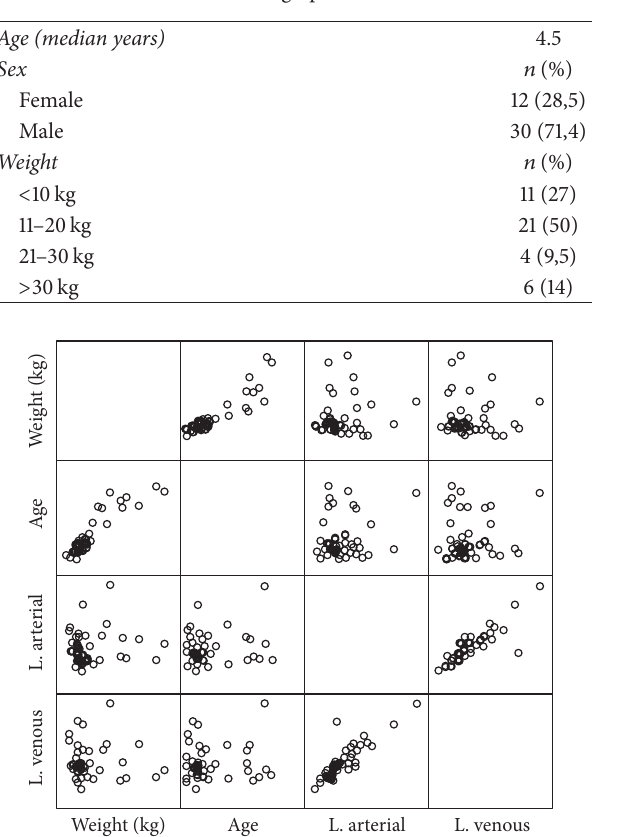
a maximum of 4.8 mmol/L. For central venous lactate, the median was 1.6 mmol/L (SD 0.9 mmol/L), with a minimum of 0.2 mmol/L and a maximum of 4.7 mmol/L.